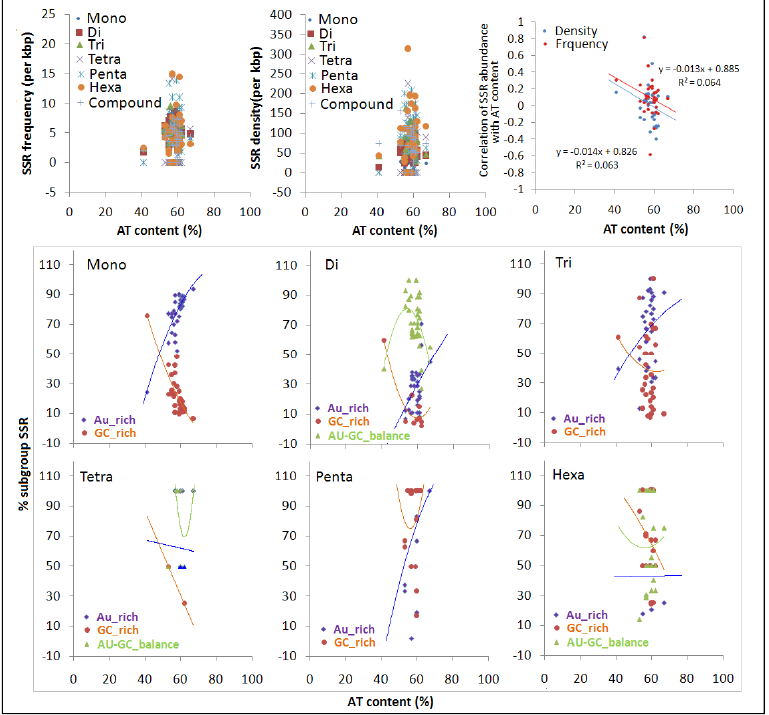
Figure 2. Relations between GC/AT content and simple sequence repeat (SSR) frequency and den- sity. Relative counts of trinucleotide repeats ranged from 0.02 in monocots to 0.45 in fungi (Table 2). In plant pre-miRNAs, trinucleotide repeats were less frequent than di- and mon- onucleotide repeats. The ACU/AGU and AUG/GUA repeats were common in all six plant taxonomic groups, whereas other trinucleotide repeat units were rare (Figure 1c). Nota- bly, most trinucleotide repeat units contained the base “U.” In dicot pre-miRNAs, “U”- containing trinucleotide repeat units were predominant, whereas in monocots, “C”-con- taining trinucleotide repeat units were predominant. The longest trinucleotide repeat unit was (GAA) 30 , which was found in monocot pre-miRNAs (Supplementary Table S2). Tetra-, penta-, and hexanucleotide repeats were less abundant than other repeats in plant pre-miRNAs (Table 2). In particular, tetranucleotide repeats were not found in fungi, algae, mosses and conifers, whereas pentanucleotide repeats were not found in algae pre- miRNAs (Figure 1c). AU-rich and AU–GC balanced tetra nucleotide repeats were domi- nant in dicot and monocot pre-miRNAs. The GC-rich penta nucleotide repeats were more abundant in mosses than in other plant pre-miRNAs. The longest penta nucleotide repeat was (AACCG) 6 with a length of 30 bp, and it was found in algal pre-miRNAs. A total of 34 different hexanucleotide repeat motifs were identified, but a common motif was not found among the six taxonomic groups of plants. However, the CCUCUU motif was more frequent in fungal pre-miRNAs. The longest hexanucleotide repeat was (CUUCCU) 13 , which was found in dicot pre-miRNAs. 3.3. Effect of Nucleotide Composition on Simple Sequence Repeat Frequency, Density and Variation within pre-microRNAs To evaluate the effects of the nucleotide composition of plant pre-miRNAs on SSR frequency, density and variation in SSR motif composition, correlations between the